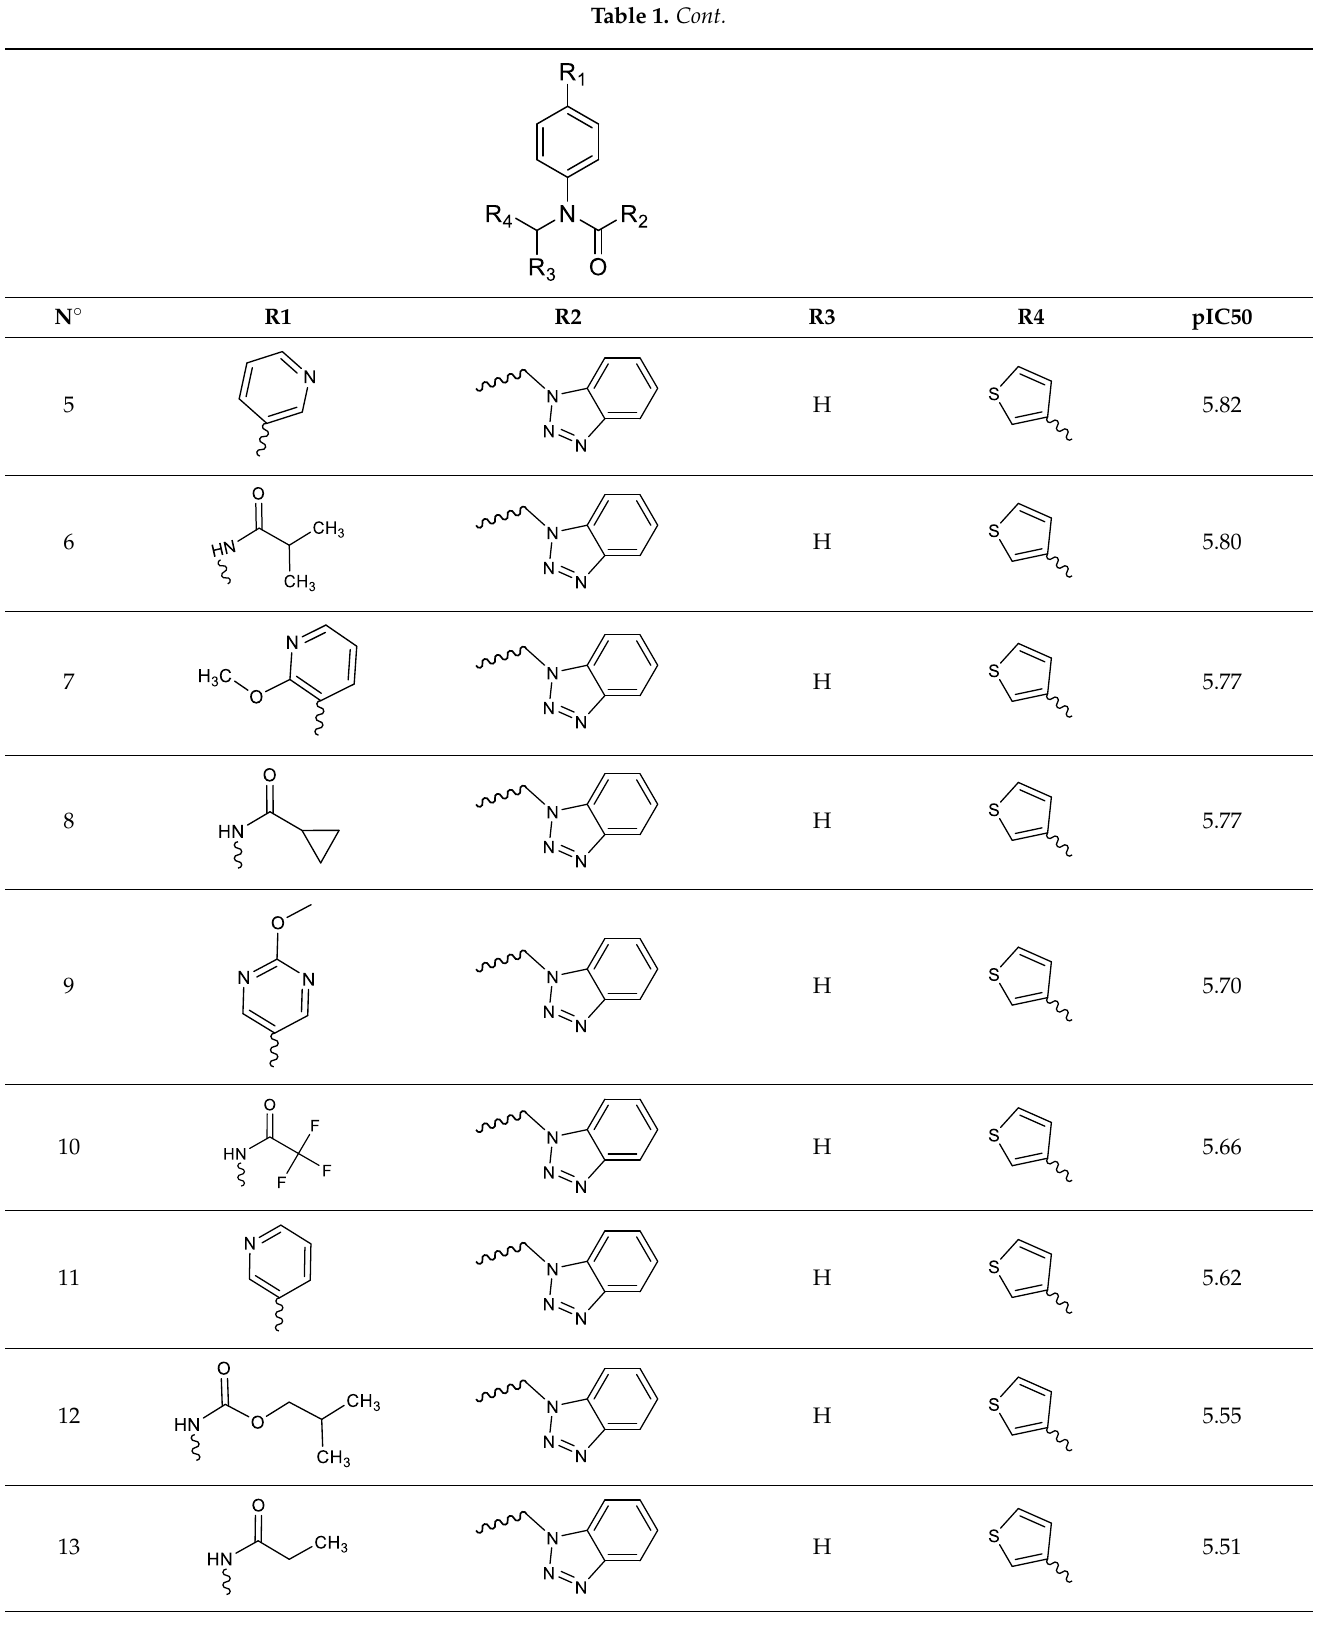
Table 1. Cont. Table 1. Chemical structures and activity experiment of 41 peptidomimetic compounds.